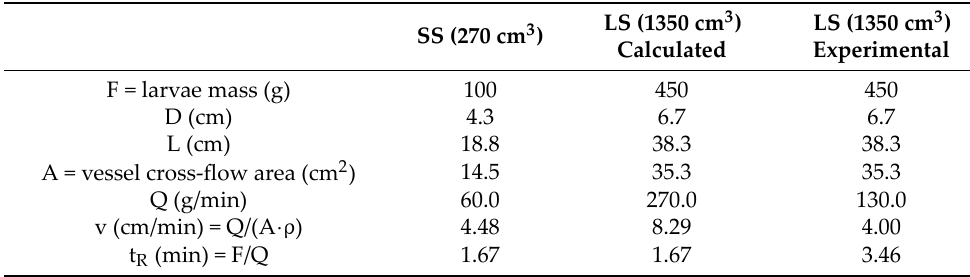
◦ C (CO 2 density = 923 kg/m 3 ).